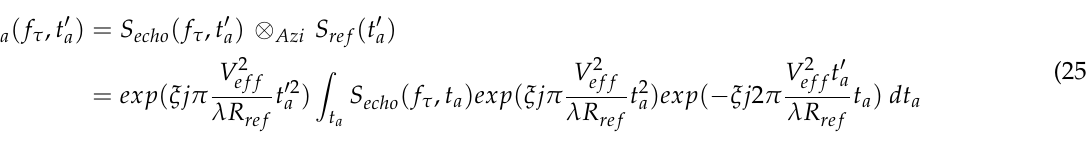
Figure 1. We use (cid:126) S G and (cid:126) V G to represent the position and velocity vector of GEO transmitter. Correspondingly, (cid:126) S L and (cid:126) V L stand for the position and velocity vector of LEO